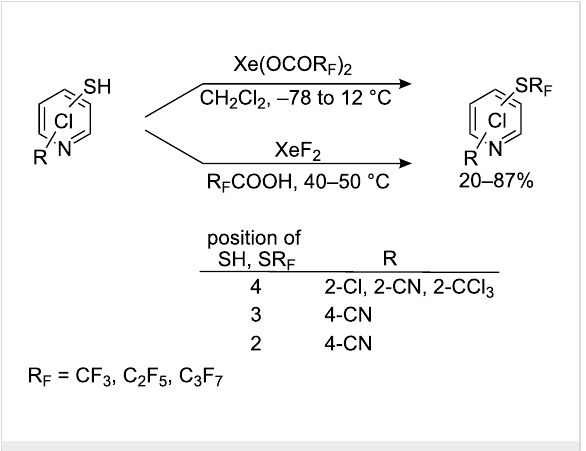
Scheme 59: Perfluoroalkylation of polychloropyridine thiols with xenon perfluorocarboxylates or XeF 2 [222,223].